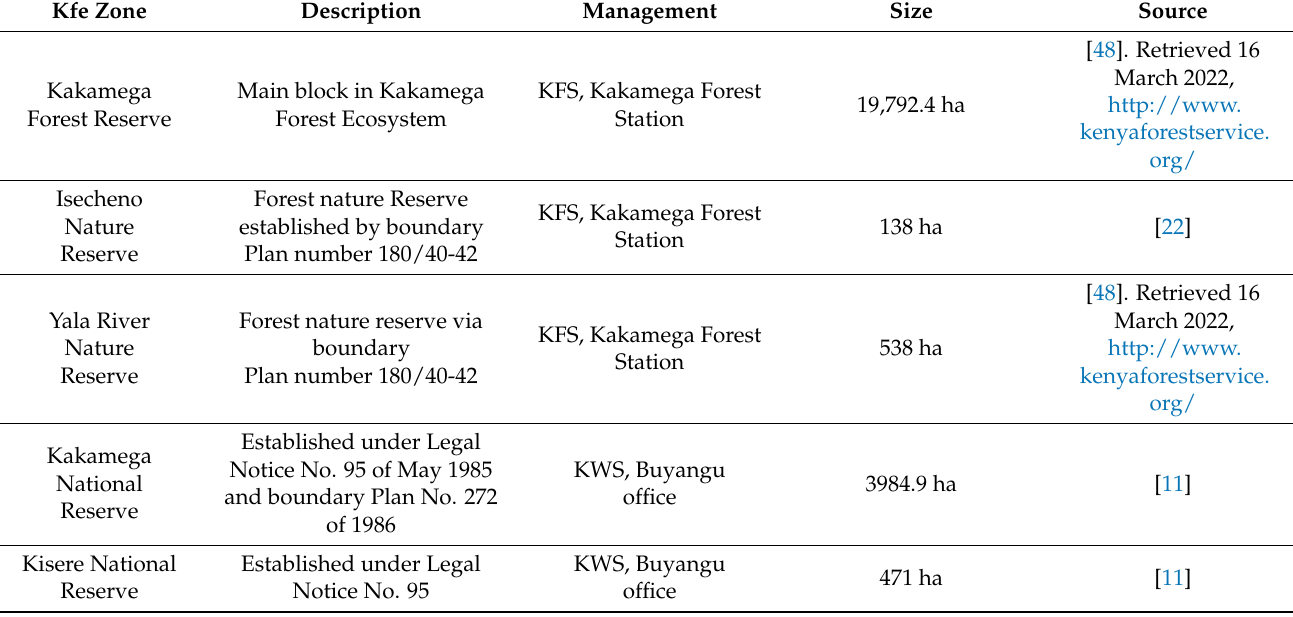
Table A1. Kakamega Forest Ecosystem (KFE) Management